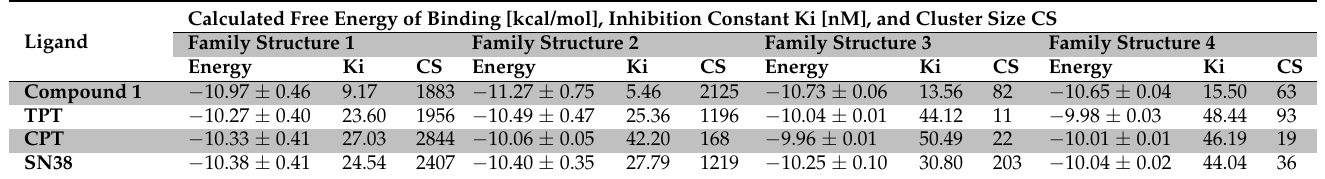
Figure 1. Structures representing the main clusters for each family structure obtained in MD simu- lations. Only ligand-interacting fragments of the receptor are shown. Dashed purple lines indicate possible hydrogen bonds for a given family of structures. Table 2. Docking analysis for receptor structures obtained in MD simulations of ligand/DNA/Topo I ternary